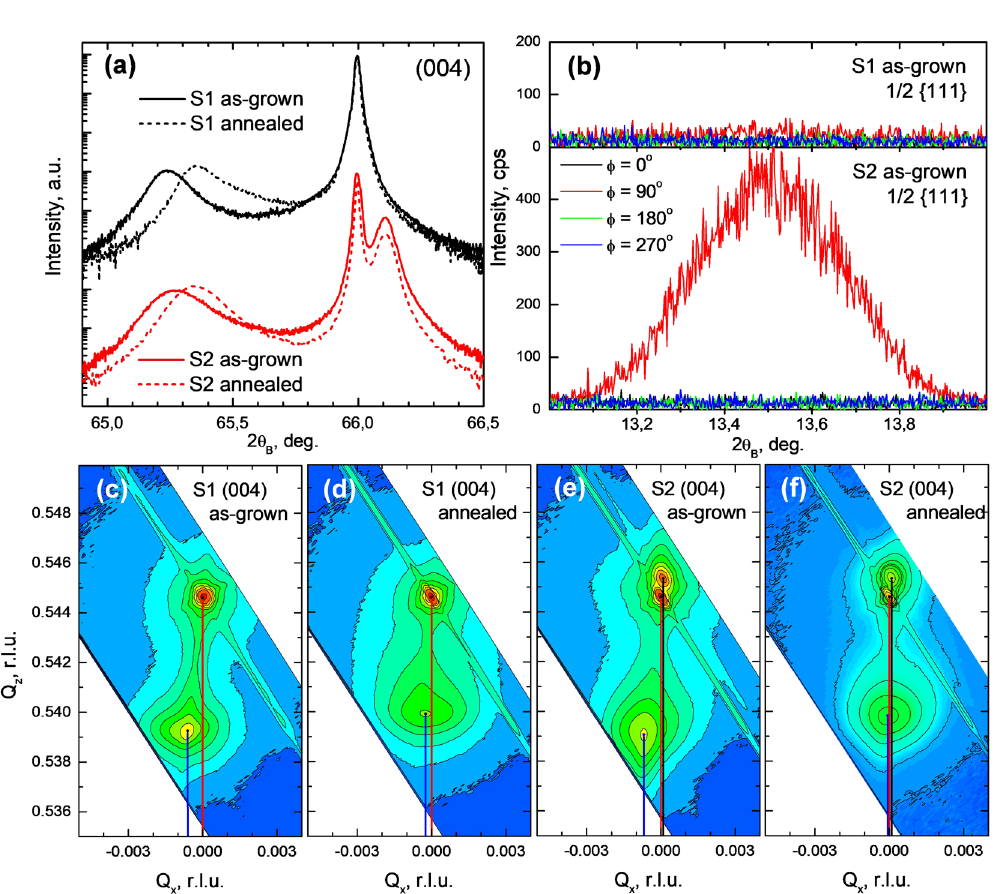
Figure 6. ( a ) XRD (004) reflection rocking-curves of the as-grown and annealed (600 °C) samples S1 and S2. ( b ) XRD measurement of CuPt-type ordering. The direct-epitaxy sample S1 shows little-to-none superlattice ½{111} reflections, while S2 clearly indicates ordering on a single set among four distinct sets of {111} planes. ( c – f ) Reciprocal-space mappings of (004) reflections of samples S1 and S2 before and after annealing (600 °C). The bismide layer tilt is visible in both as-grown samples, the angle decreases after the